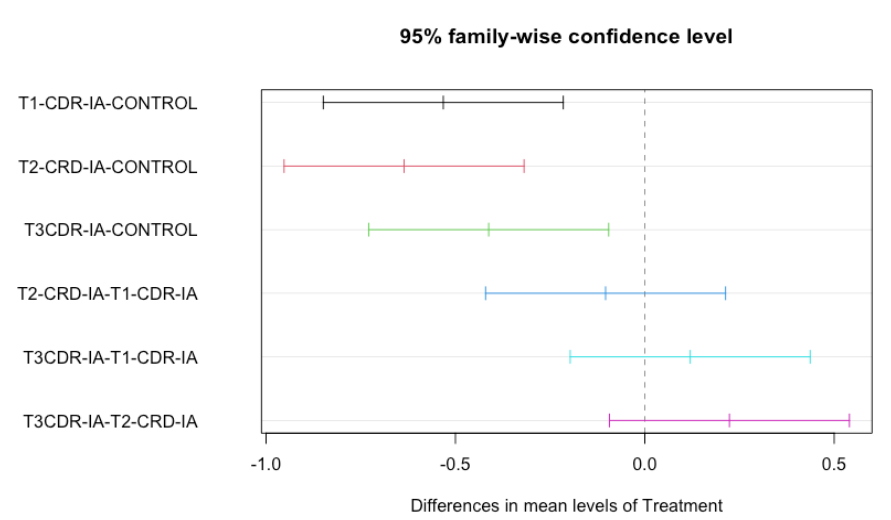
Figure A6. Confidence Intervals for Tukey Test for culicines.